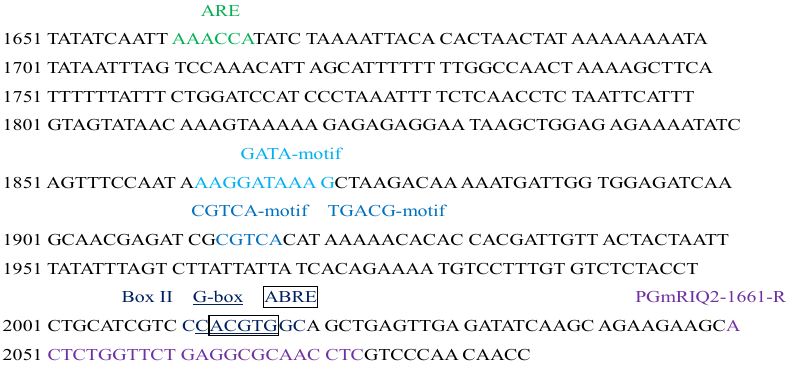
Figure 4. Sequence analysis of the GmRIQ2 promoter ( PGmRIQ2 ). The explanations of the gene sequences marked by different colors and black boxes are shown in Table 4.